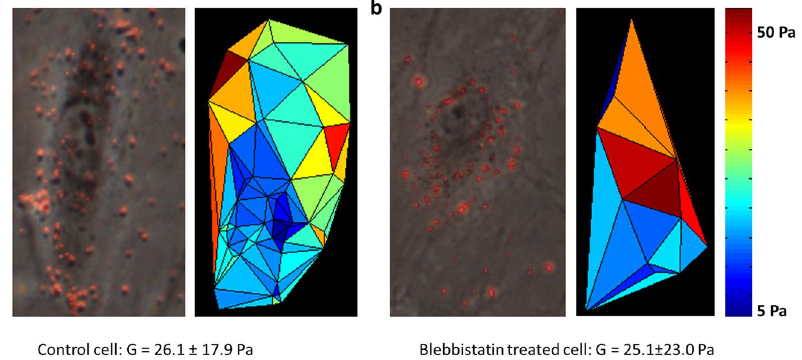
Figure 6. Example of shear modulus microscopy. Brightfield images with superimposed beads and the corresponding stiffness maps for a control cell ( a ) and a cell following blebbistatin treatment ( b ). The bead locations were used to create a Delaunay triangulation along the surface of the cell and each triangle is colored as the mean of the shear moduli of the three bead at the vertexes of the triangle.